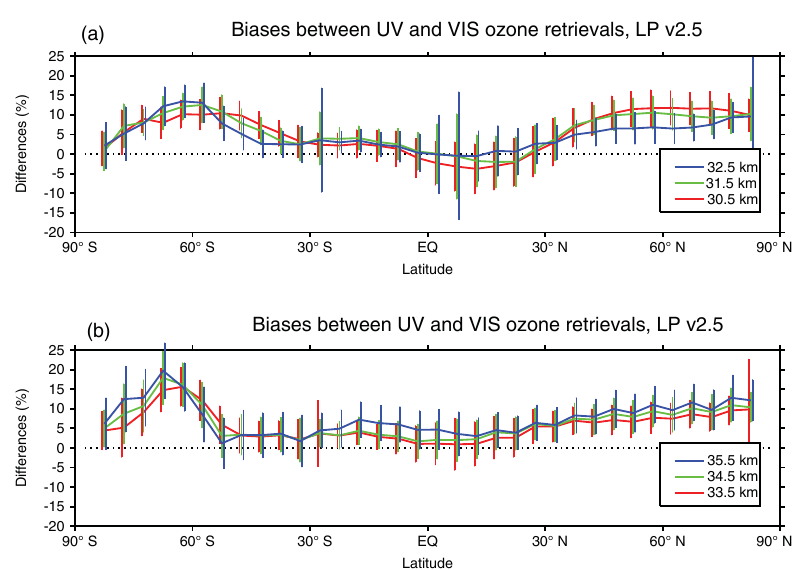
Figure 10. Mean biases between the UV and VIS OMPS LP ozone retrievals in version 2.5 as functions of latitude. Panel (a) shows differ- ences at 30.5, 31.5 and 32.5km, while panel (b) presents differences at 33.5, 34.5 and 35.5km. Error bars indicate 1 σ standard deviations of the